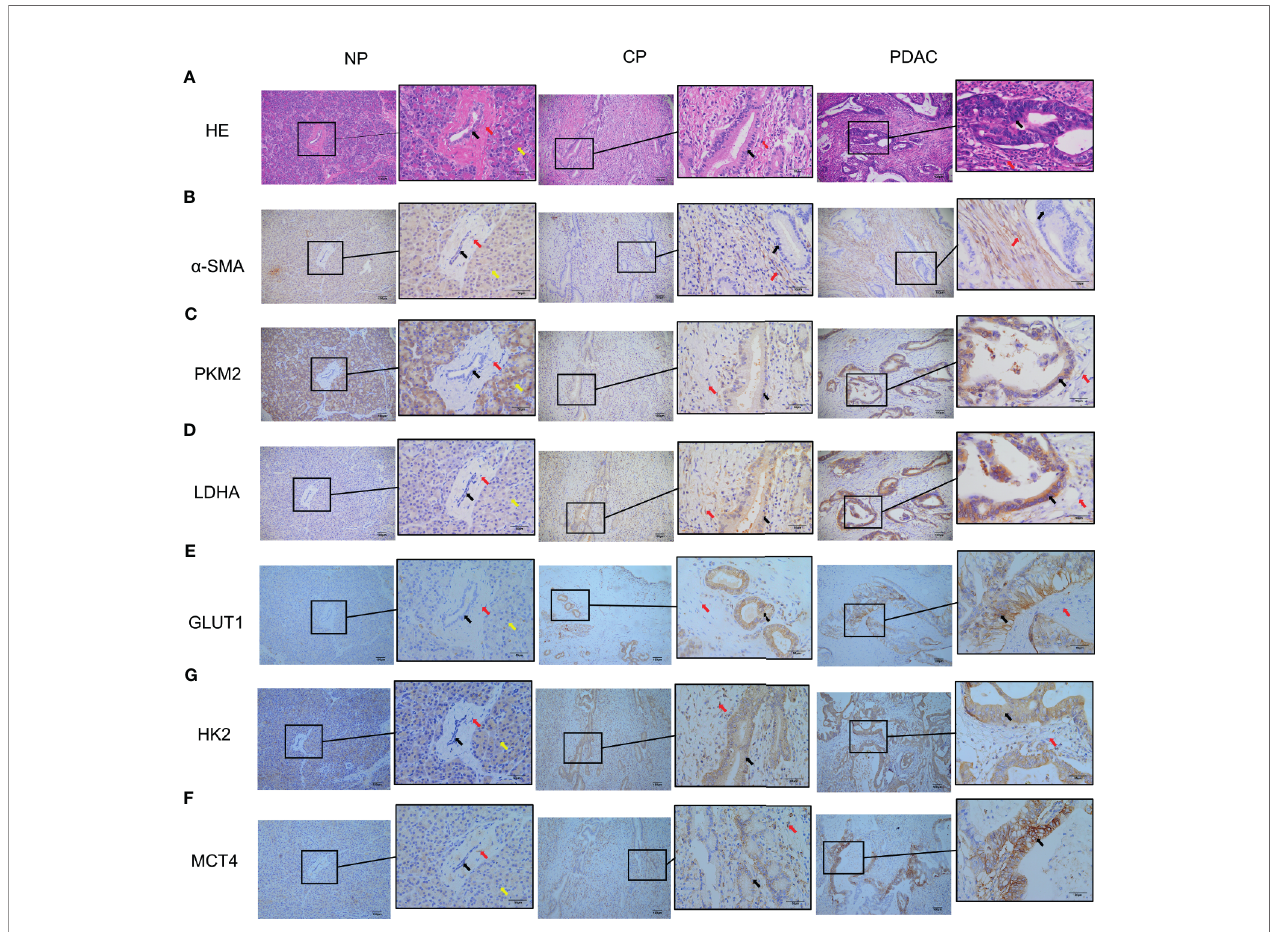
FIGURE 6 | Immunohistochemistry showed that the a -SMA and glycolysis markers in the pancreatic tissues of humans in the normal group, CP group and PDAC group gradually increased (100X and 400X; black arrow: cancer/normal epithelial duct cells; red arrow: stromal cells ( fi broblasts, PSCs); yellow arrow: acinar cells). (A) HE in normal/CP/PDAC human pancreas; (B) a -SMA in normal/CP/PDAC human pancreas; (C) PKM2 in normal/CP/PDAC human pancreas; (D) LDHA in normal/CP/PDAC human pancreas; (E) GLUT1 in normal/CP/PDAC human pancreas; (F) HK2 in normal/CP/PDAC human pancreas; (G) MCT4 in normal/CP/PDAC human pancreas.